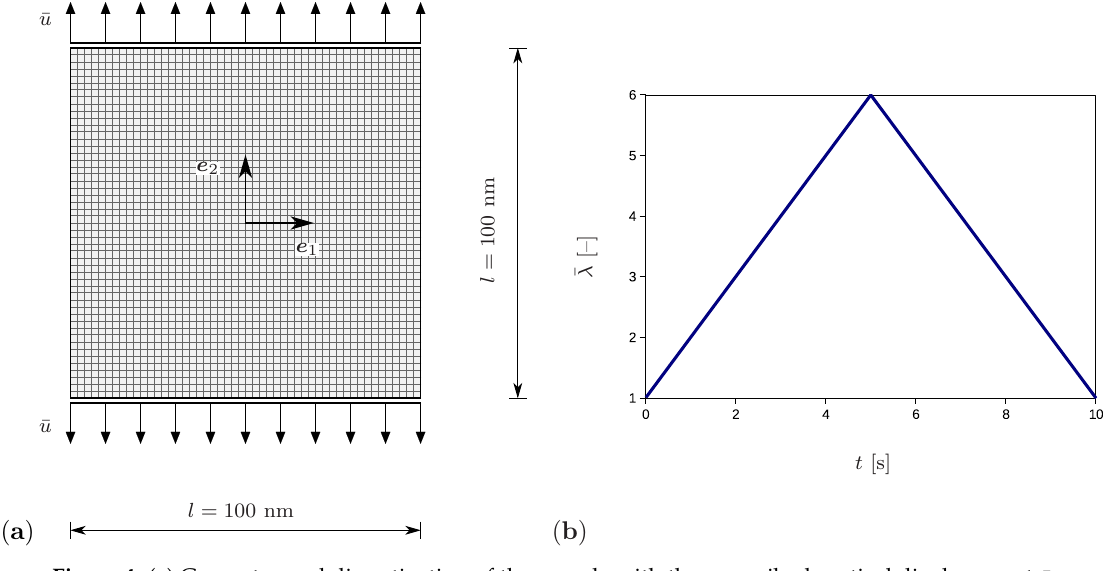
Figure 4. ( a ) Geometry and discretization of the sample with the prescribed vertical displacement ¯ u and side length l . ( b ) The applied stretch ¯ λ = ( l + 2 ¯ u ) / l as a function of